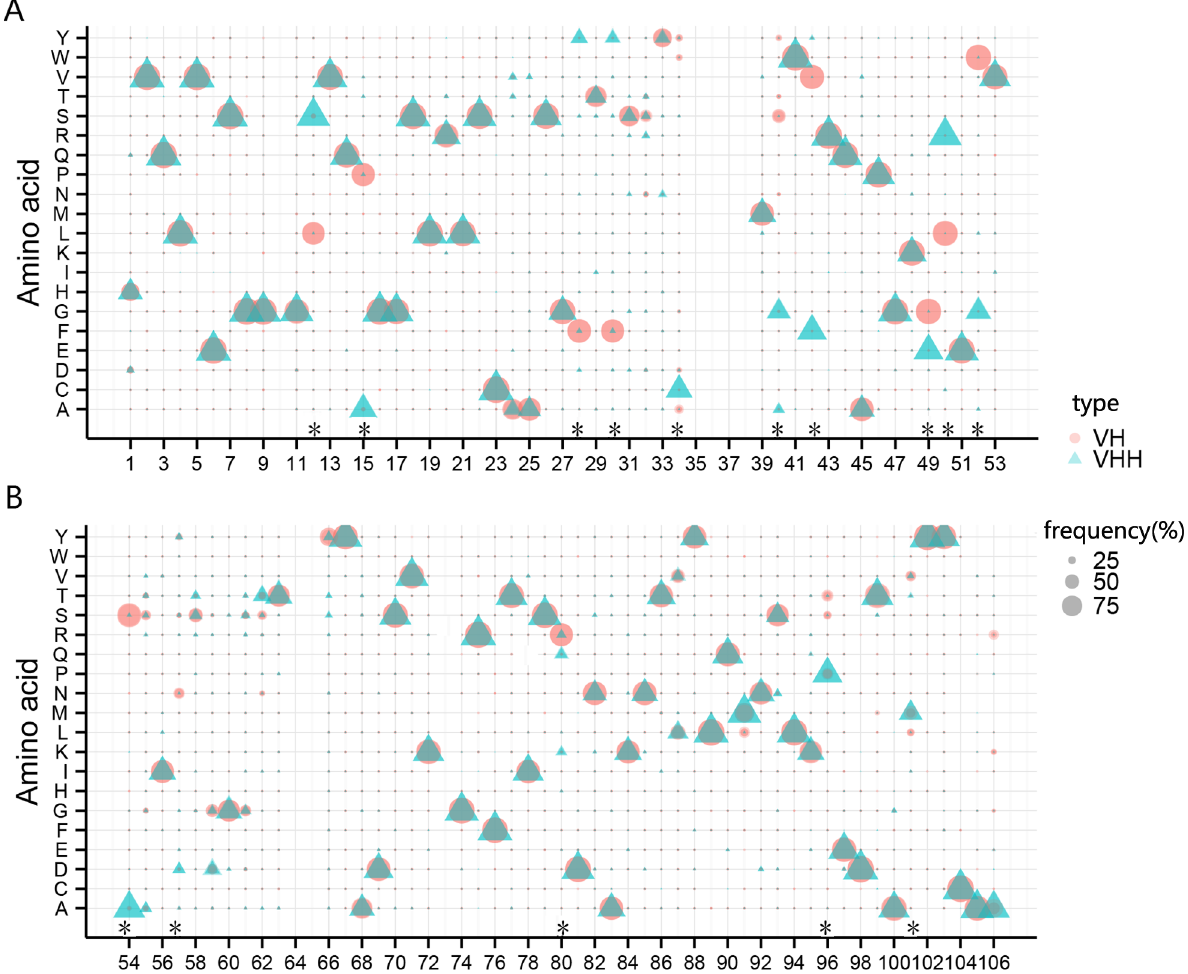
Fig 4. Amino acids frequency distribution of each position for VH and VHH clones. The horizontal axis lists the actual positions of the amino acids in IMGT references of the Arabian camel. The vertical axis lists abbreviations of twenty different amino acids. The circles denote VH clones and the triangles, VHHs. The size represents the proportion of clone number. The asterisk-labeled positions represent the amino acids which have little consistency between VH and VHH